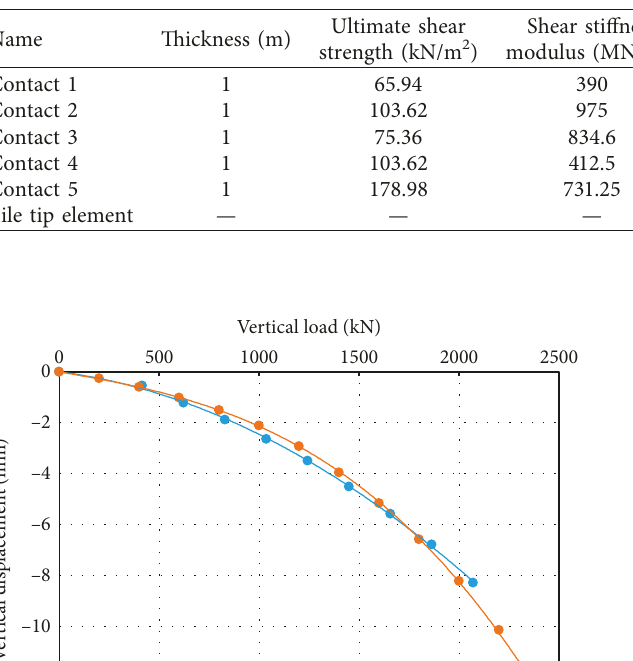
Table 4: Characteristics of pile end characteristics and pile-soil contact parameters.